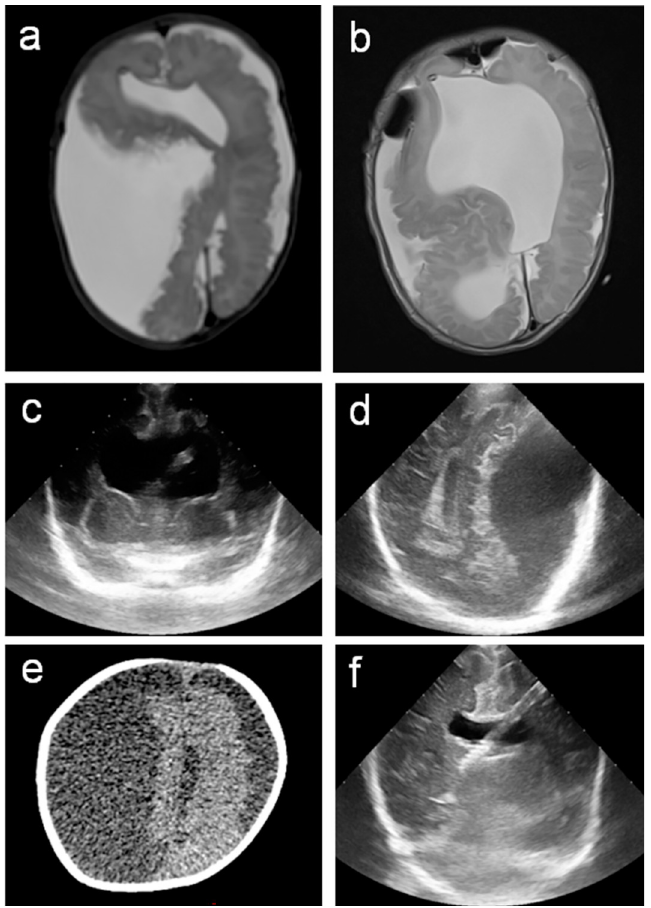
Fig 2. Complications due to over drainage after VPS implantation. T2 sequence magnetic resonance imaging control one month after VPS implantation in a 35 days old newborn with aquaeductal stenosis and hydrocephalus (a and b). a; Bilateral hygroma complication with midline shift due to overdrainage (valve pressure at 5 cm H 2 0). The patient had no clinical symptoms correlation. b; Post operative control imaging showing hygroma regression. The valve pressure was changed intra operatively to 8 cm H 2 O. c; Transfontanelle ultrasonography control right after VPS implantation in a 50 days old newborn with aquaeductal stenosis and hydrocephalus. The intra ventricular catheter is identified with correct position in the right ventricle and the valve pressure was initially settled at 5 cm H 2 0. d; Two weeks later at regular visit transfontanelle ultrasonography control showing bilateral hygroma. The patient presented no clinical symptoms. e; pre operative low dosis computer tomography control confirming the diagnosis. f; Transfontanelle ultrasonography control 3 days after hygroma evacuation and valve pressure correction to 8 cm H 2 O (VPS: ventriculoperitoneal